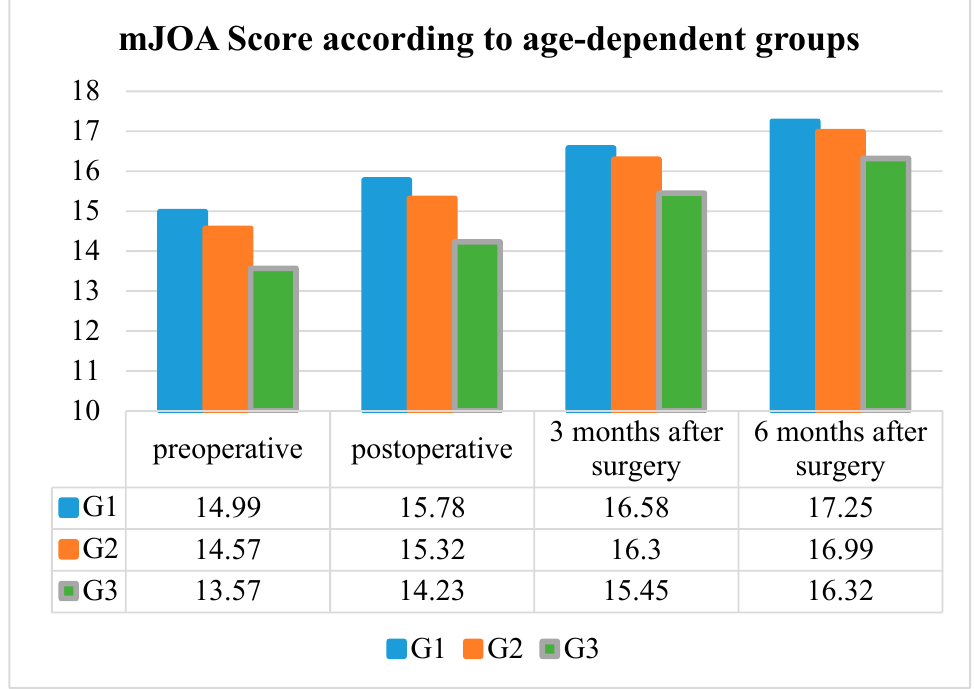
Figure 2. Modified Japanese Orthopedic Association Score (mJOA Score) according to the age- Figure2. ModifiedJapaneseOrthopedicAssociationScore(mJOAScore)accordingtotheage-dependent dependent groups (G1–G3). groups (G1–G3).